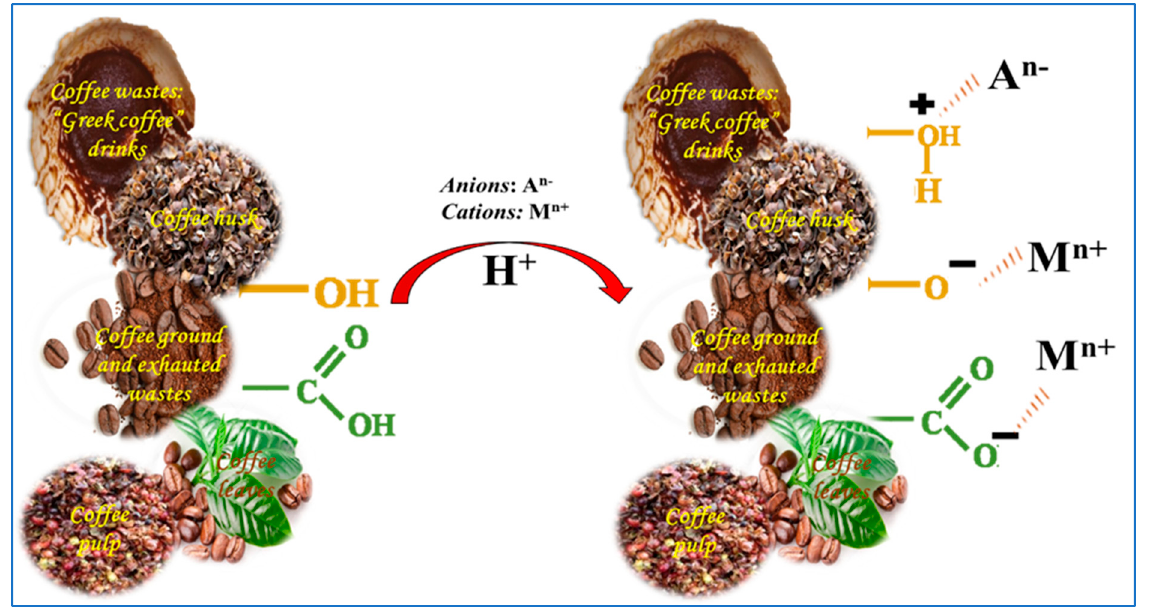
Figure 4. Mechanisms of adsorption of anionic and cationic species using sorbents derived from coffee cultivation and processing.